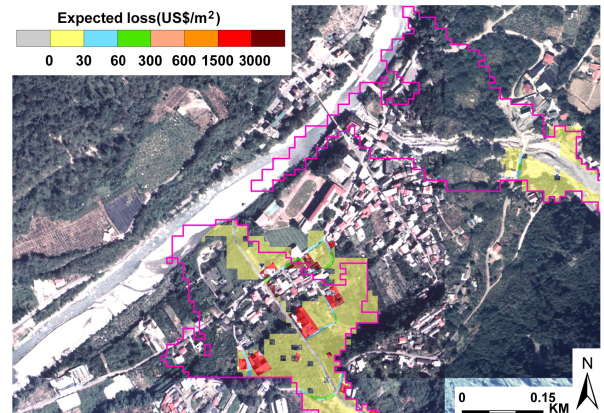
Fig. 6. Map showing the expected total loss caused by debris flows of the Nos. 1 and 2 Torrents for an event with 50-year return pe- Figure 6. Map showing the expected total loss caused by debris flows of the No. 1 and No. 2 3 riod after mitigation structures were installed. The pink line is the Torrents for an event with 50-year return period after mitigation structures were installed. The 4 boundary of the simulated debris flow deposits in Fig. pink line is the boundary of the simulated debris flow deposits in Fig. 2. 5